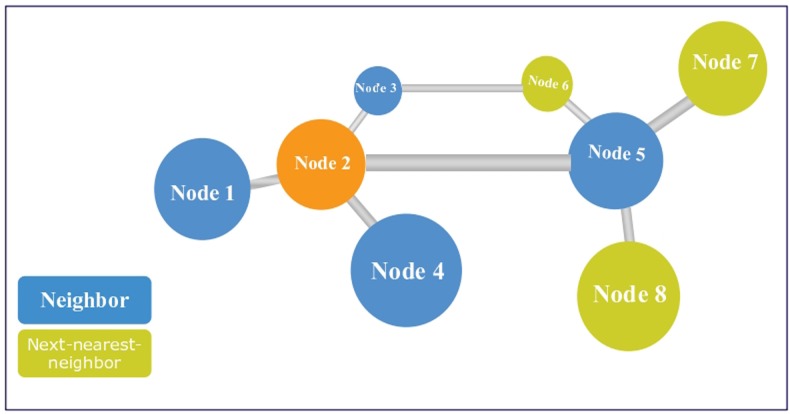
Illustration of next-nearest-neighbor node.